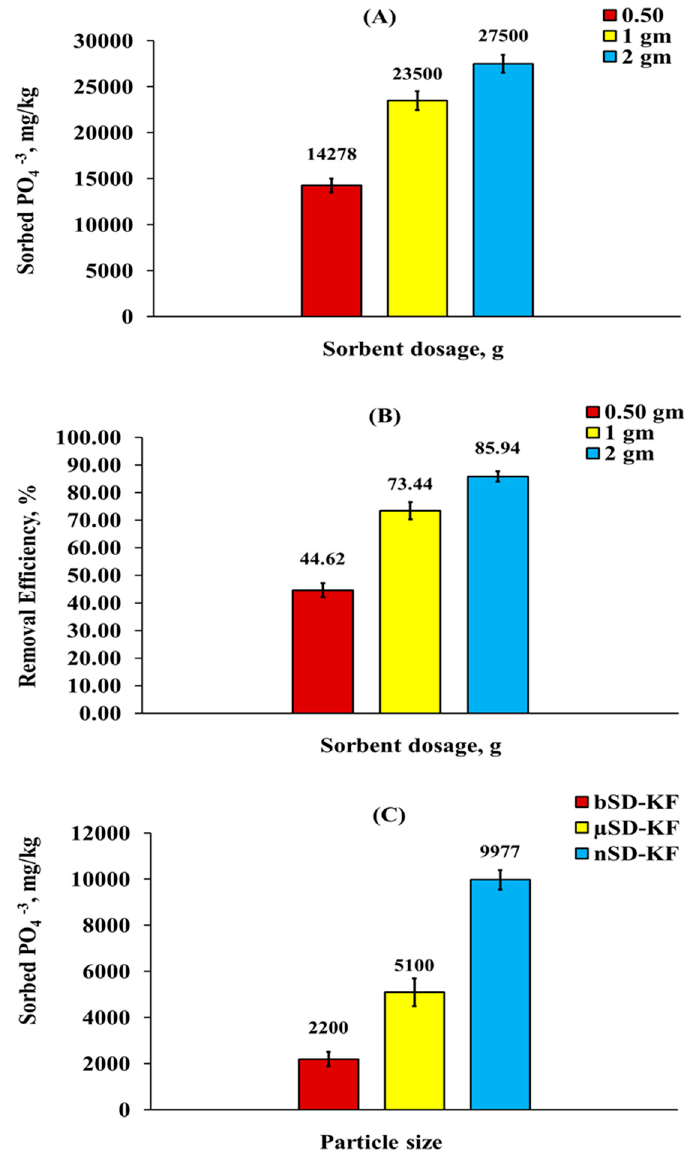
Figure 3. E ff ect of nSD-KF dose on PO4 − 3 sorption amount ( A ) and removal e ffi ciency ( B ) from aqueous Figure 3. Effect of nSD-KF dose on PO4 − 3 sorption amount ( A ) and removal efficiency ( B ) from solution. ( C ): e ff ect of particle size of sawdust on PO4 − 3 sorption aqueous solution. ( C ): effect of particle size of sawdust on PO4 − 3 sorption amount.